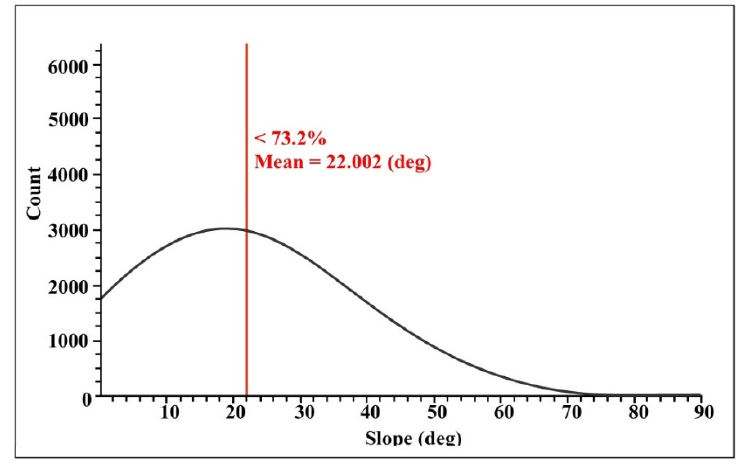
Figure 19. Statistics of the slope distribution.